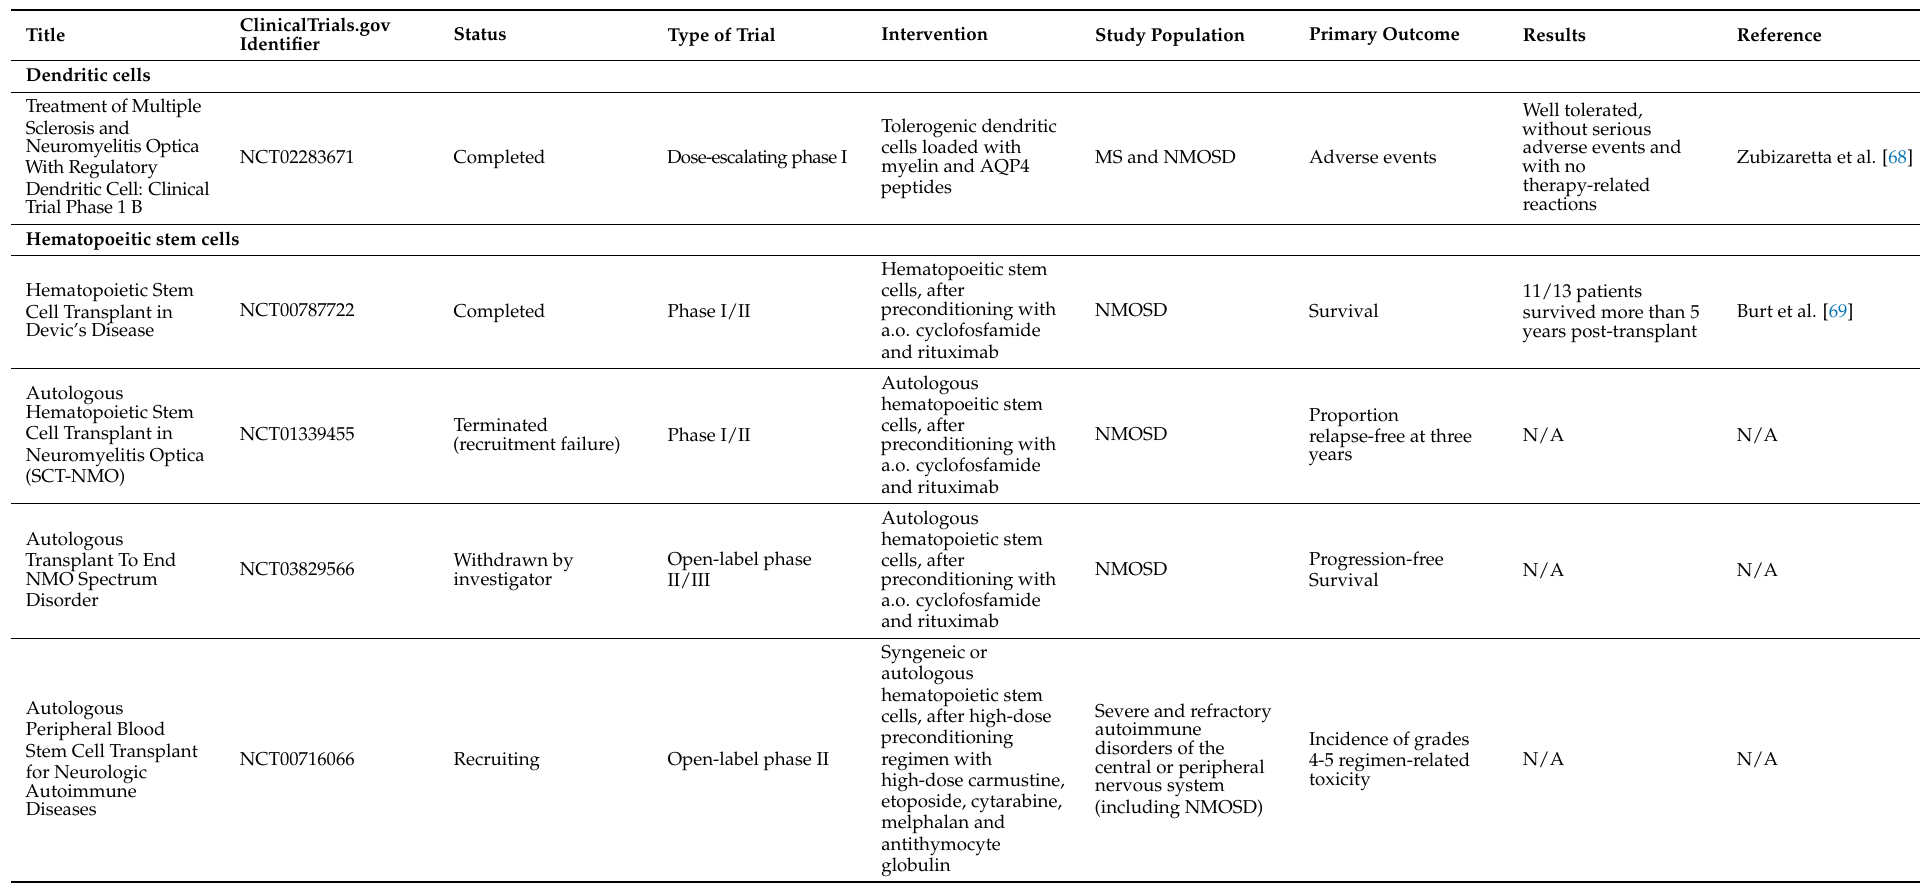
Table 1. Overview of completed, ongoing and withdrawn clinical trials with cell therapy in the field of NMOSD and MOGAD, as registered in the ClinicalTrials.gov database. Abbreviations used: MOGAD, MOG antibody-associated disease; AQP4, aquaporine 4; a.o., amongst others; N/A, not applicable; MS, multiple sclerosis; NMOSD, neuromyelitis optica spectrum disorder; CAR, chimeric antigen receptor; CD, cluster of differentiation; EDSS, Expanded Disability Status